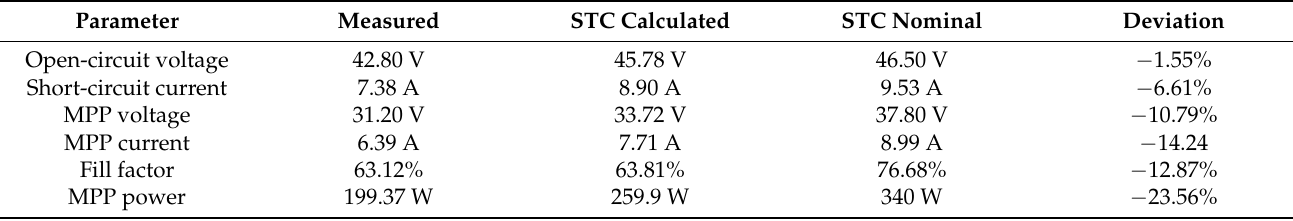
Table 10. PV module 2 (washed) I ‐ V curve test results.